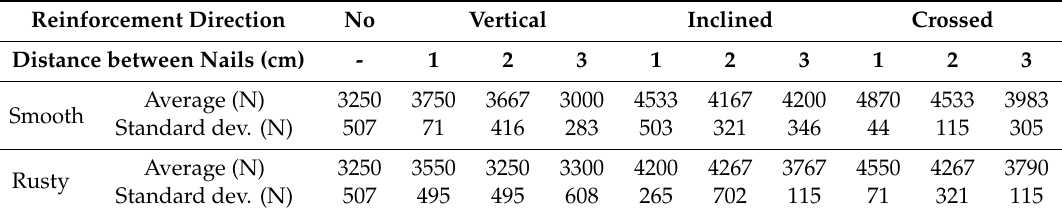
Table 2. Maximum bending force recorded for sample with bending force perpendicular to the layer’s direction.